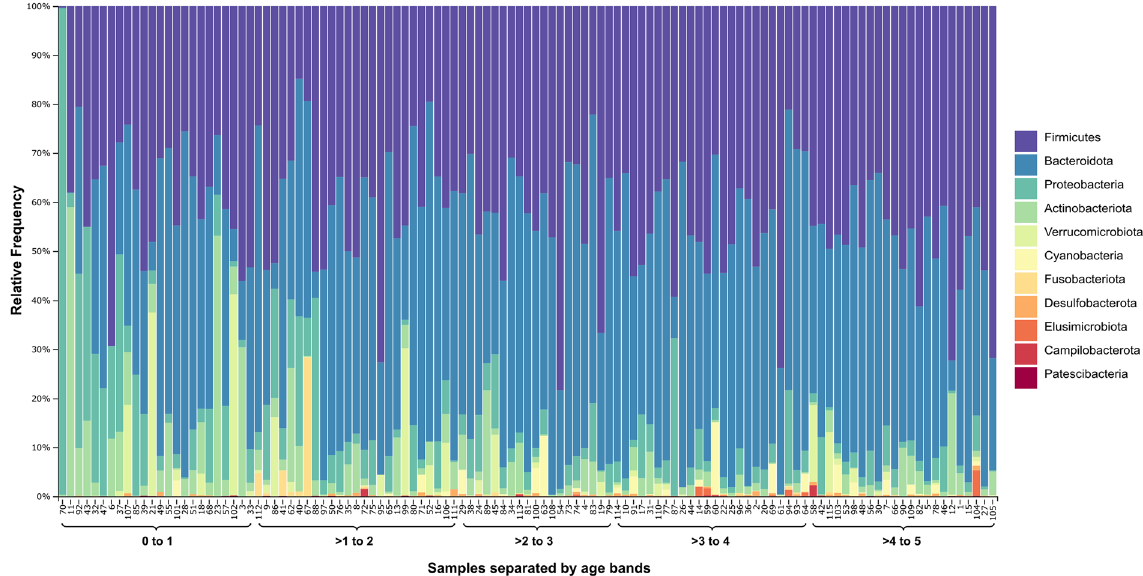
Figure 1. Taxonomic profiles of participant samples at phylum level. The brackets on the x-axis show the different age bands by year and samples within each band are ordered by increasing age. Features appearing in less than five samples, as well as unassigned and non-bacterial features were removed to simplify visualization.